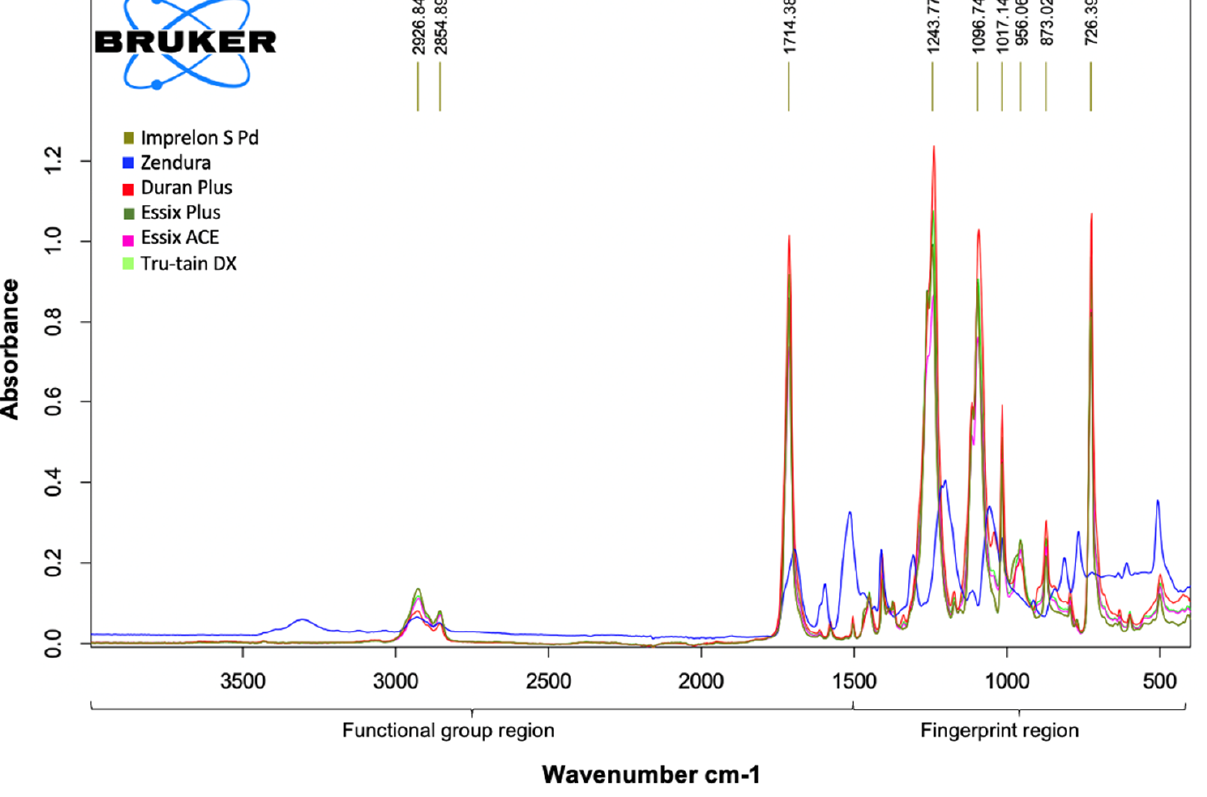
Figure 8. Superimposition of FTIR spectra of all investigated as received materials (Group 1).